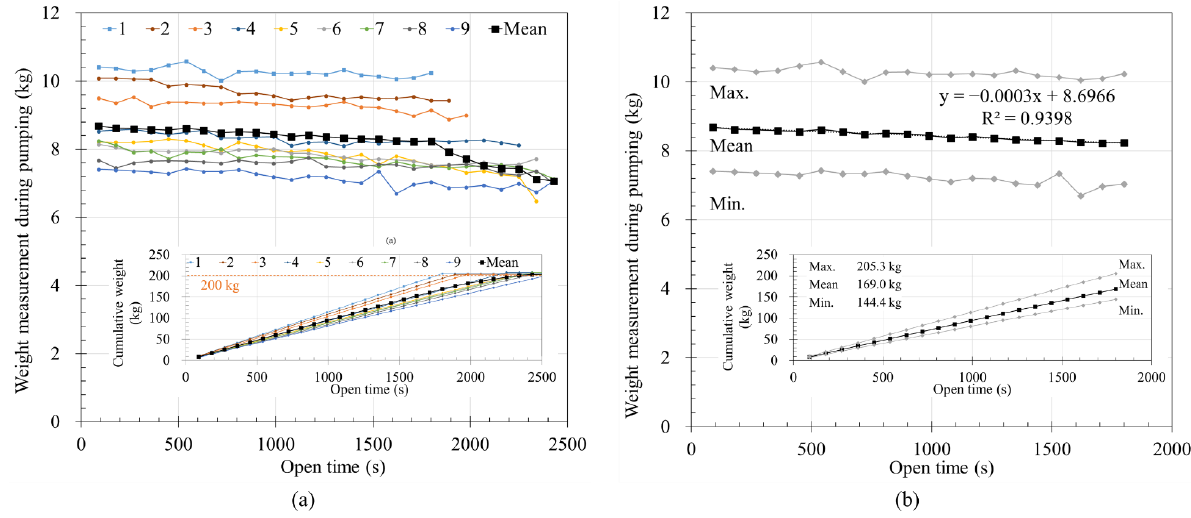
Figure 10. Pumpability test results: ( a ) measured weight of mortar during pumping and cumulative weight; ( b ) max. min. and mean value of mortar weight measured during pumping and cumulative weight (0 – 1800 s).